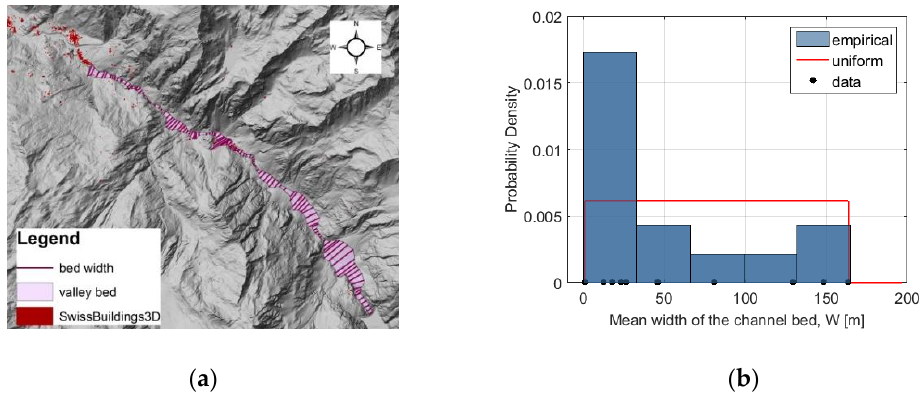
Figure 5. ( a ) Mauvoisin dam downstream area with the valley bed (pink area) and lines indicating its width at different locations; ( b ) empirical data on the averaged width of the channel bed, 𝑊 , and distribution fitted to the data.